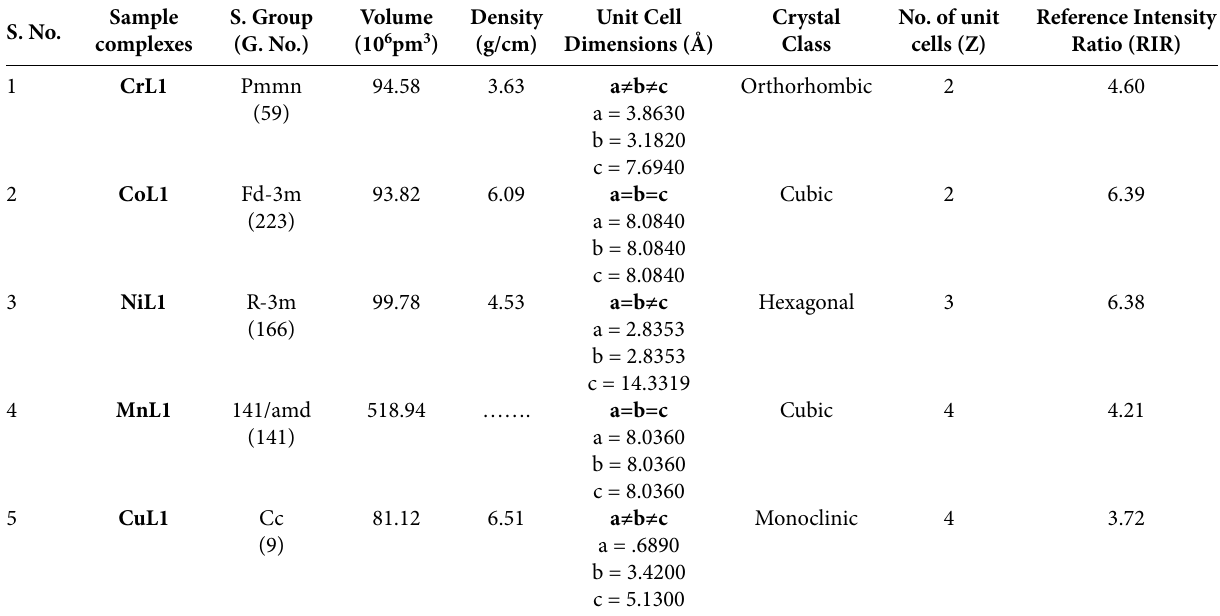
Table 2. Crystallographic data and observed refinement parameters for complexes 4-8 S. No.